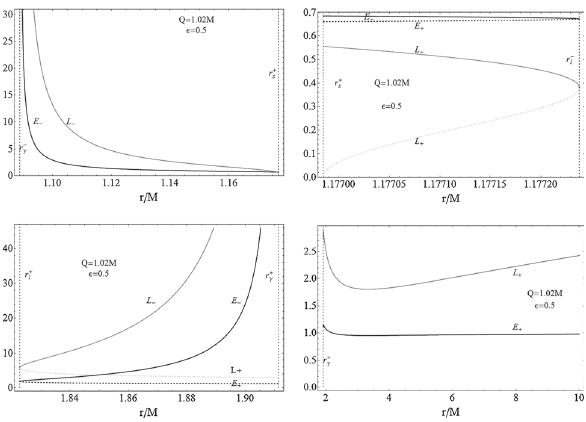
√ Fig. 7 Class : M < Q ≤ 5 /( 2 6 ) M and (cid:9)(cid:9) (cid:2) − < (cid:2) < (cid:9) (cid:2) − . Parameter choice is as follows: Q = 1 . 02 M and (cid:2) = 0 . 5. Then (cid:9)(cid:9) (cid:2) − = 0 . 215376, (cid:9) (cid:2) − = 0 . 564915, r + = 1 . 17698 M , r − = 1 . 08866 M , r + = 1 . 91134 M , γ γ s = 1 . 17724 M , and r + = 1 . 82276 M . Circular orbits exist with r − l l angular momentum L = L + ( gray curve ) and energy E = E + ( black curve ) in r − γ < r < r + s ( upper left plot ); L = L ± in r + s ≤ r < r − l ≤ r < r + = L − in ( upper right plot ) and r + γ ( bottom left plot ); L l r ≥ r + γ ( bottom right plot ). The angular momentum L − ( gray dotted curve ) and the energy E − ( black dashed curve ) are also